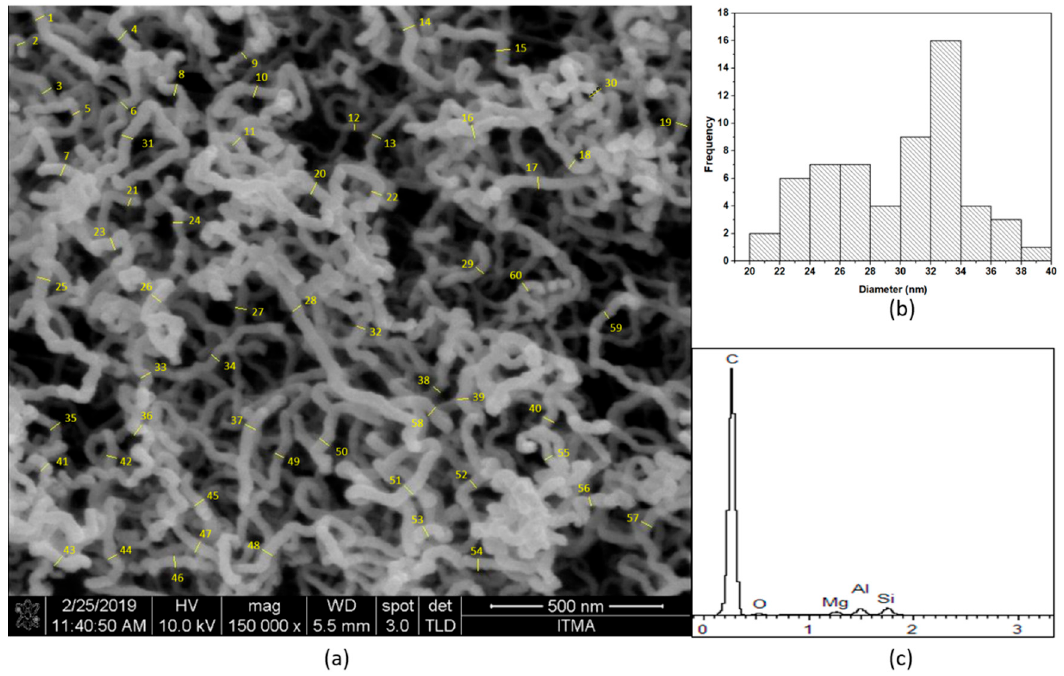
Figure 6. ( a ) Micrograph image of CNT monolith at optimum condition using FESEM; ( b ) size distribution of CNTs growth at optimum condition; and ( c ) EDX